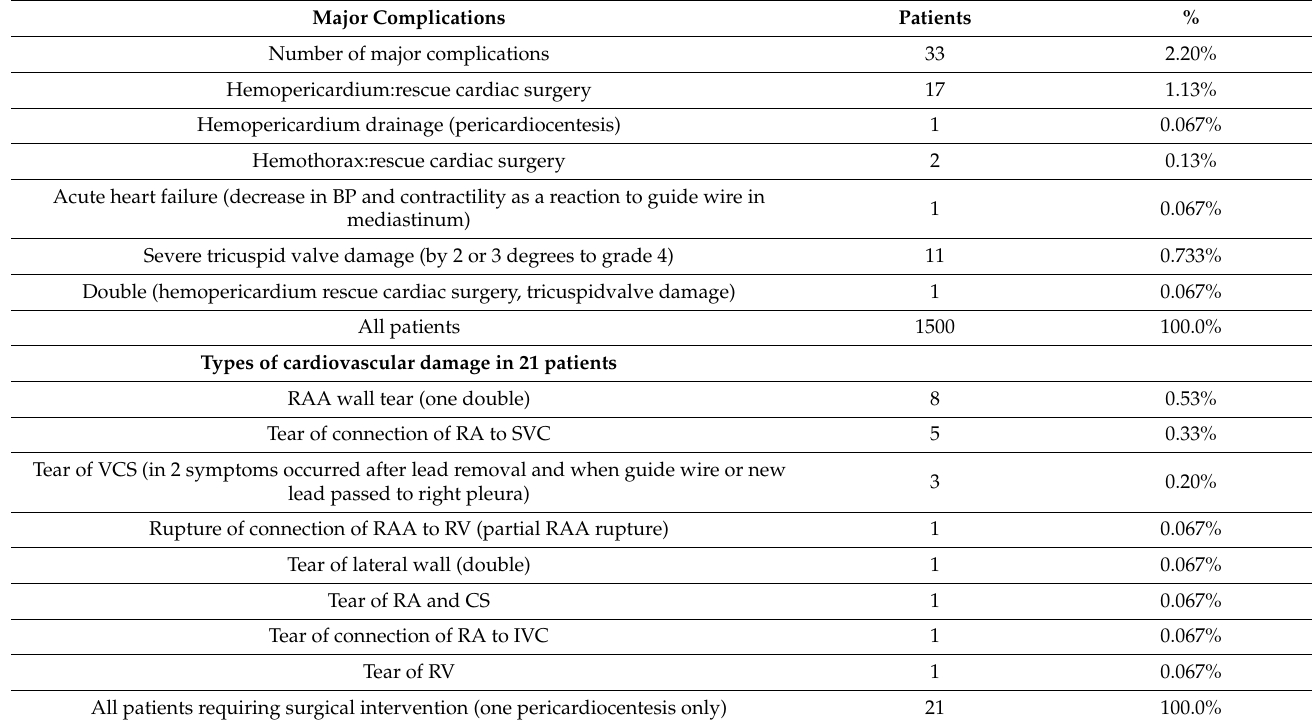
Table 4. Analysis of major